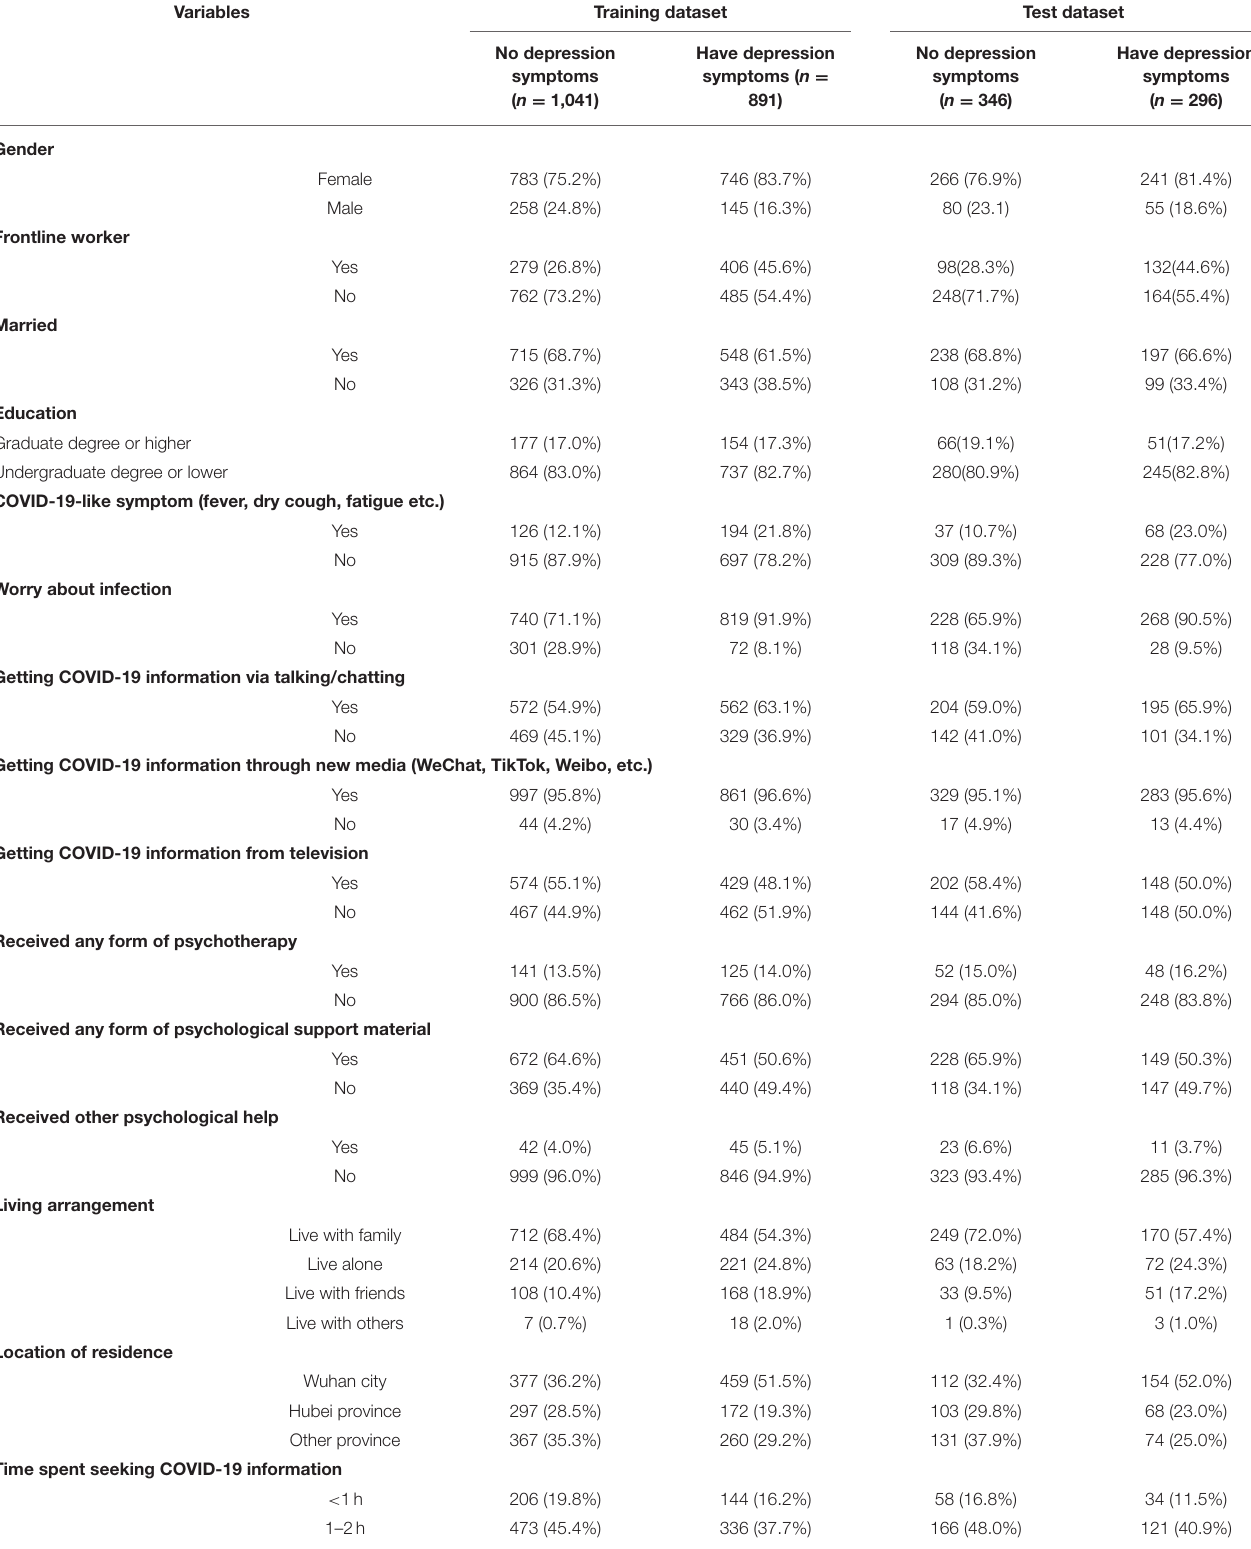
TABLE 1 | Demographic and variable